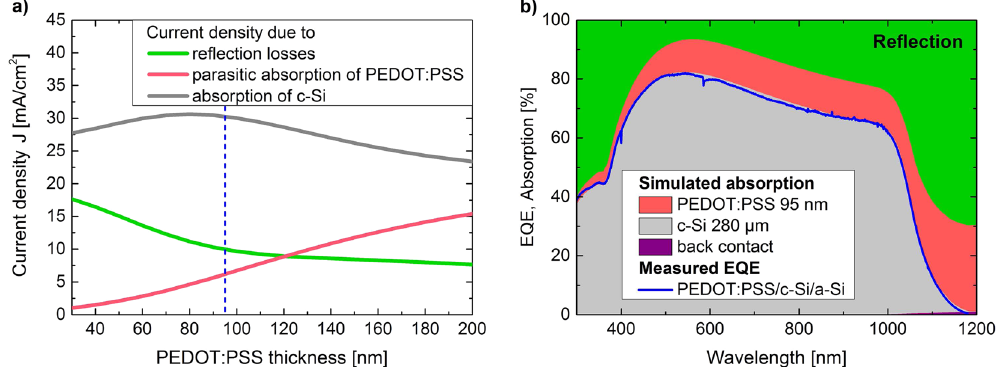
Figure 4. Simulation of the optical response of the PEDOT:PSS/c-Si/a-Si layer stack. ( a ) Simulated maximal current densities expected due to the absorption in the c-Si wafer as well as due to losses by reflection and by parasitic absorption of PEDOT:PSS for varying polymer thicknesses. ( b ) Reflection and absorption in a solar cell with 95 nm of PEDOT:PSS compared to the measured EQE spectrum of the here presented PEDOT:PSS/c- Si/a-Si solar